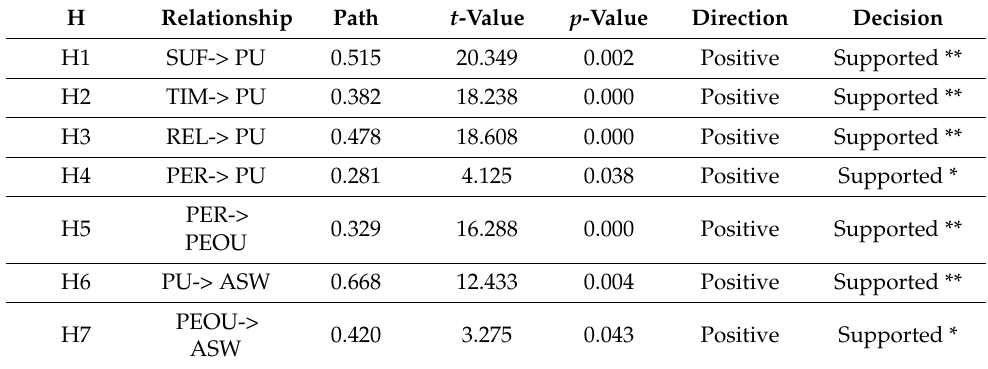
Table 8. Hypotheses-testing of the research model (significant at ** p ≤ 0.01, * p < 0.05).